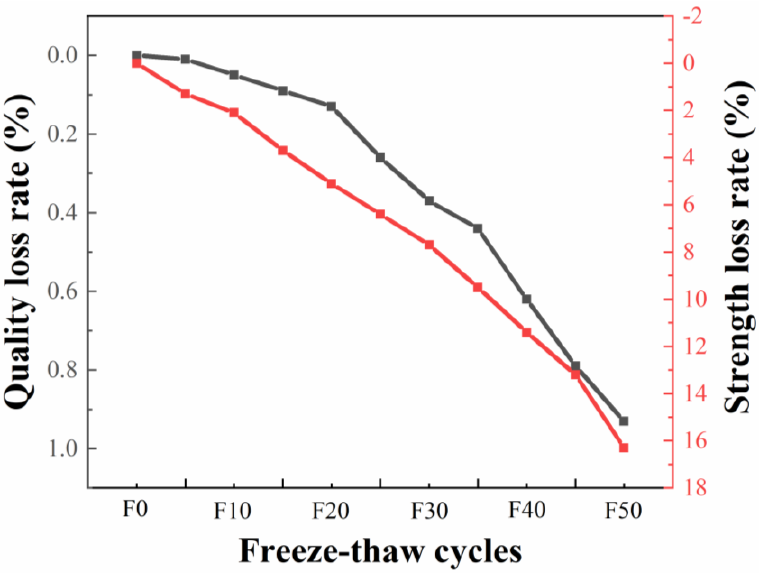
Figure 16. Effect of freeze – thaw cycles on properties of MGS sintered brick.